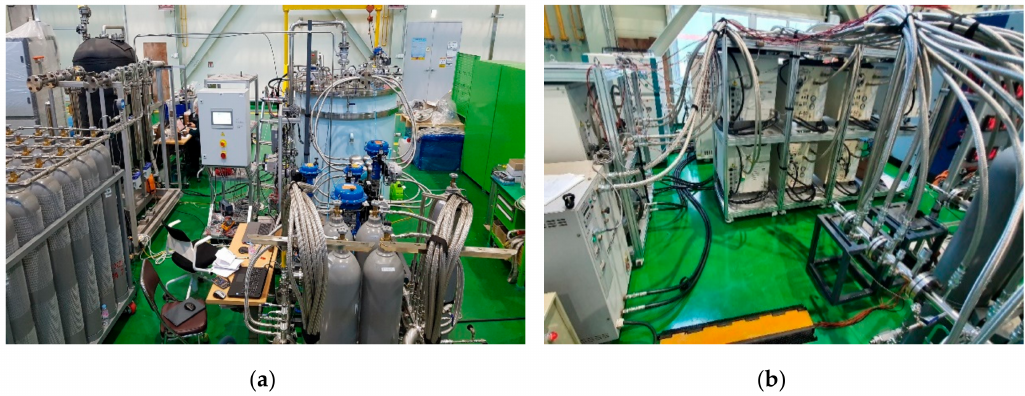
Figure 4. The constructed reverse Brayton cryogenic system: ( a ) cold box and pressure regulating system (PRS) and ( b ) compressor